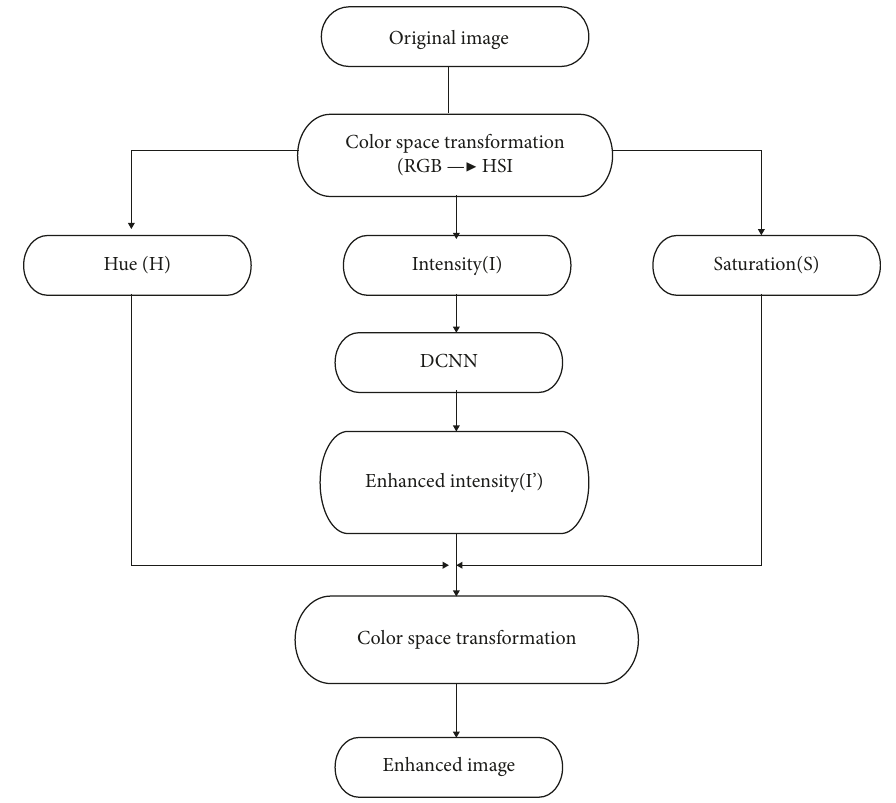
Figure 2: Proposed algorithm